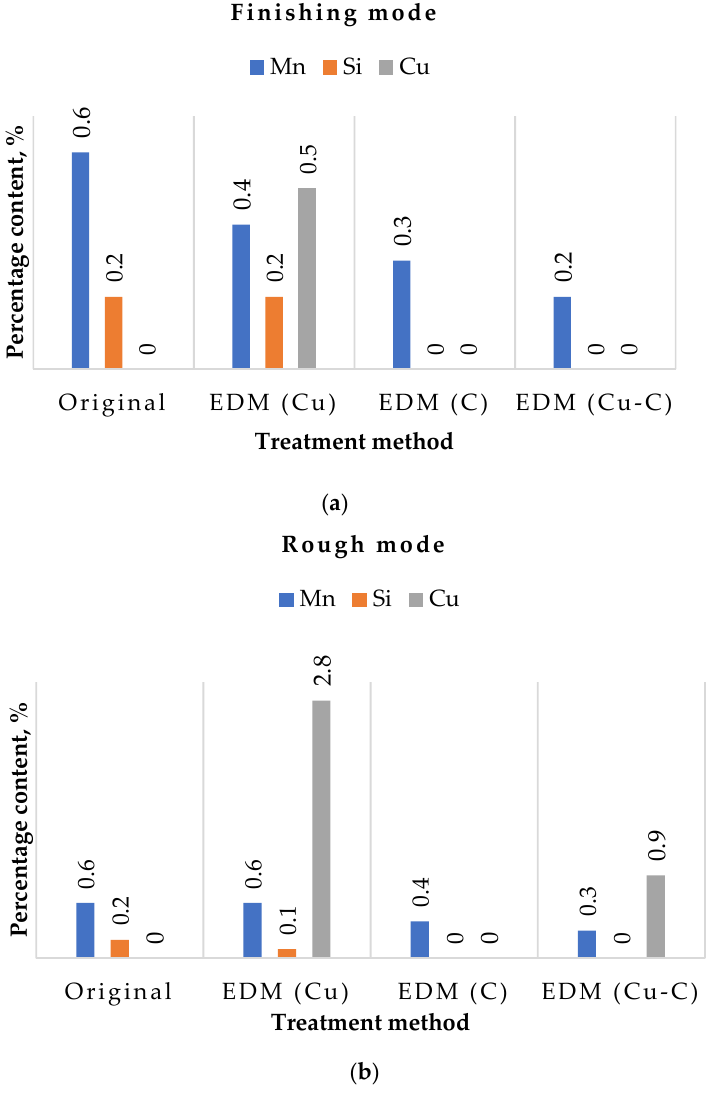
Figure 9. Elemental composition of samples before and after EDM: ( a ) in finishing mode; ( b ) in draft mode.